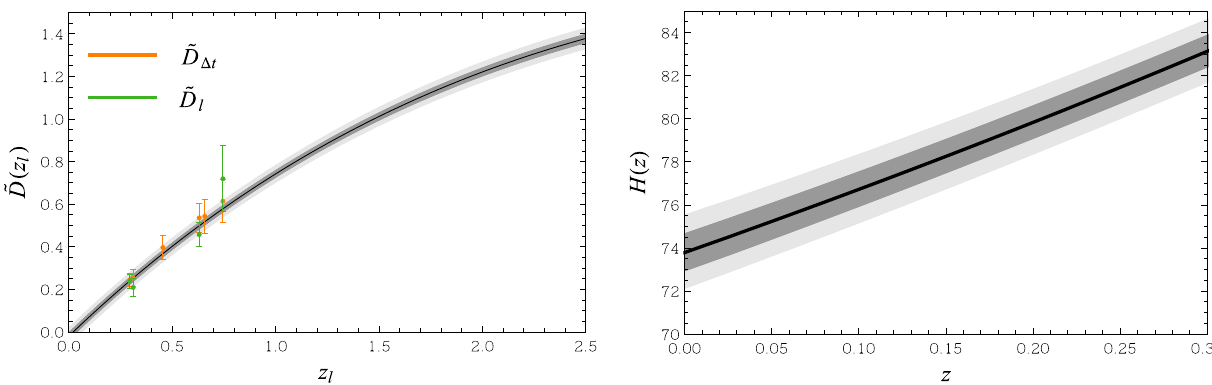
Fig. 2 Left panel: ˜ D ( z l ) vs z l with 1 σ and 2 σ CL regions, reconstructed from H0LiCOW sample data plus other data (SN+CC+BAO). Right panel: H ( z ) vs z with 1 σ and 2 σ CL regions, enlarged in the redshift range z < 0 . 3, and reconstructed from the combined data SN + BAO + CC + H0LiCOW SN+BAO+CC (bottom-right). From SN+BAO+CC analy- sis, we find H 0 = 67 . 85 ± 1 . 53 km s − 1 Mpc − 1 . Figure